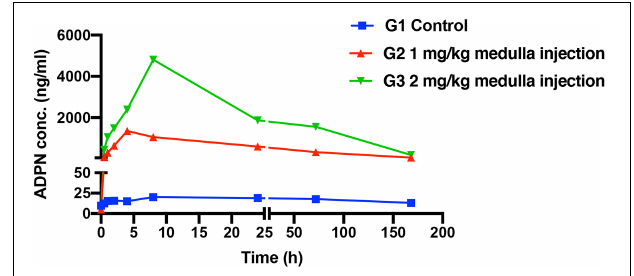
FIGURE 1 | The serum concentrations of adiponectin (ADPN) based on medulla injections, n = 5.